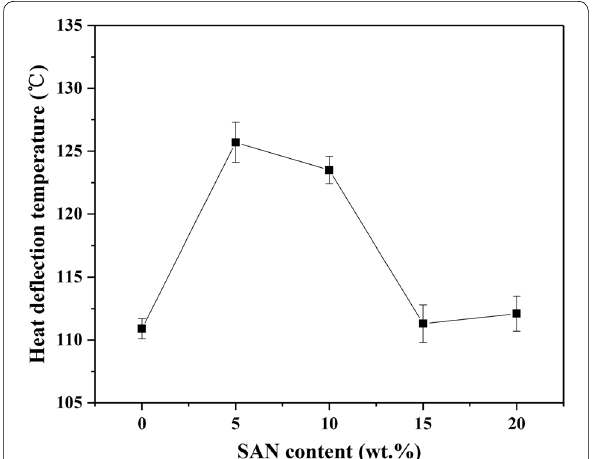
Fig. 8 Impact strength of PP and SAN/PP blends